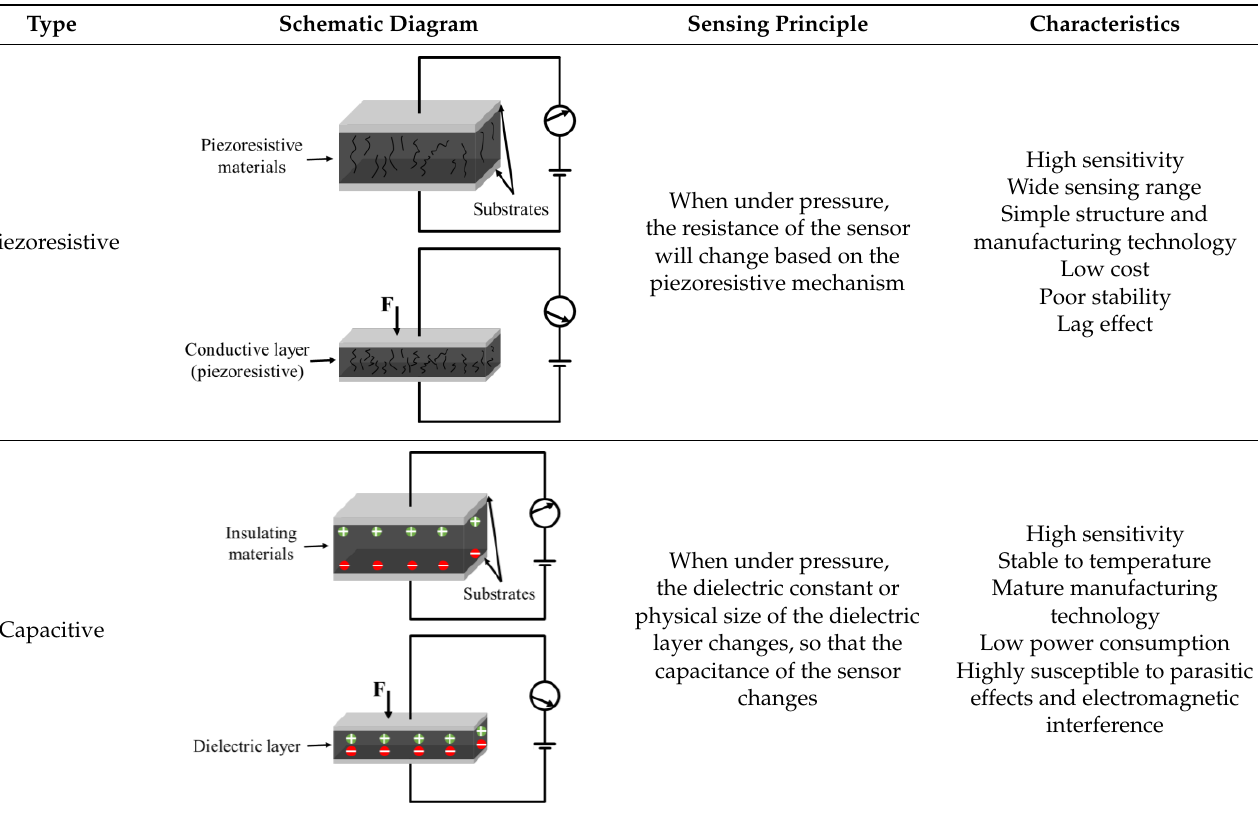
Table 1. The comparison of different types of flexible pressure sensors.